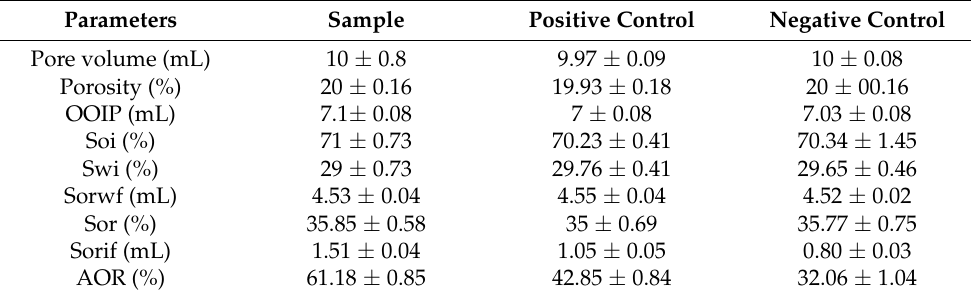
Table 2. Enhanced oil recovery from the sand-packed column using recombinant iturin